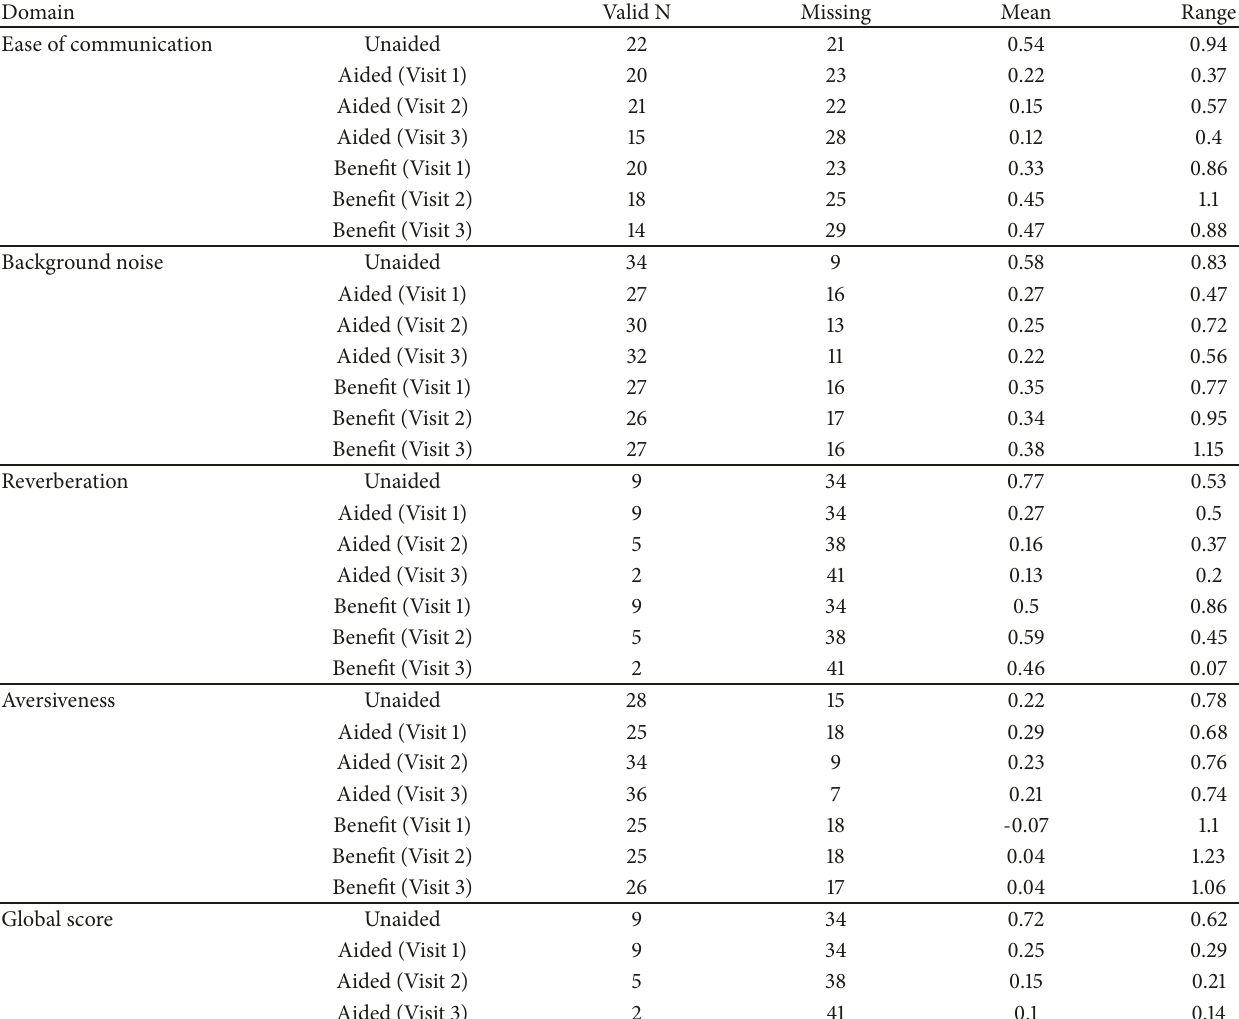
Table 4: C-PHAB scores for all question domains for three visits.